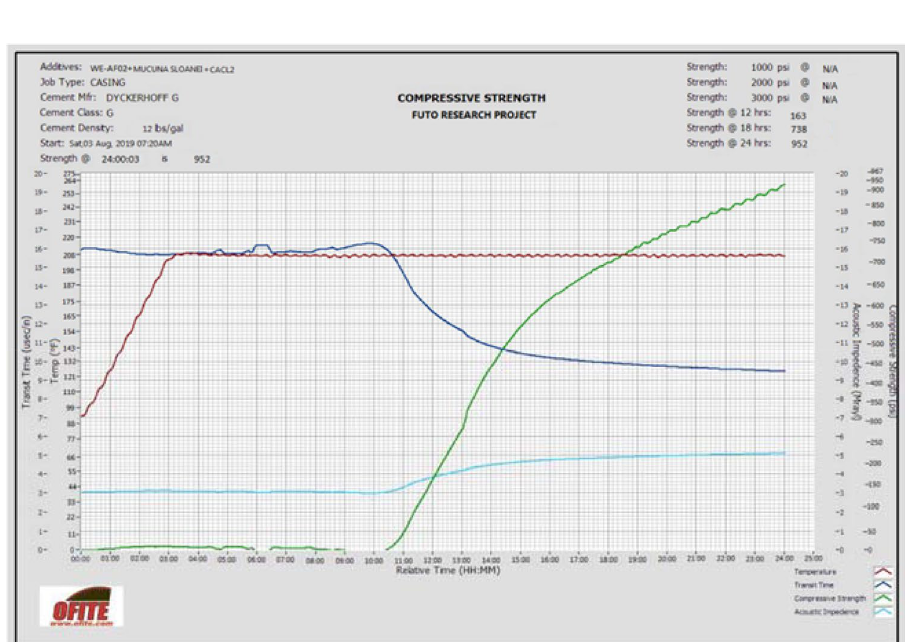
Fig. 9 Compressive strength chart for Mucuna solannie at 150 °F (65.6